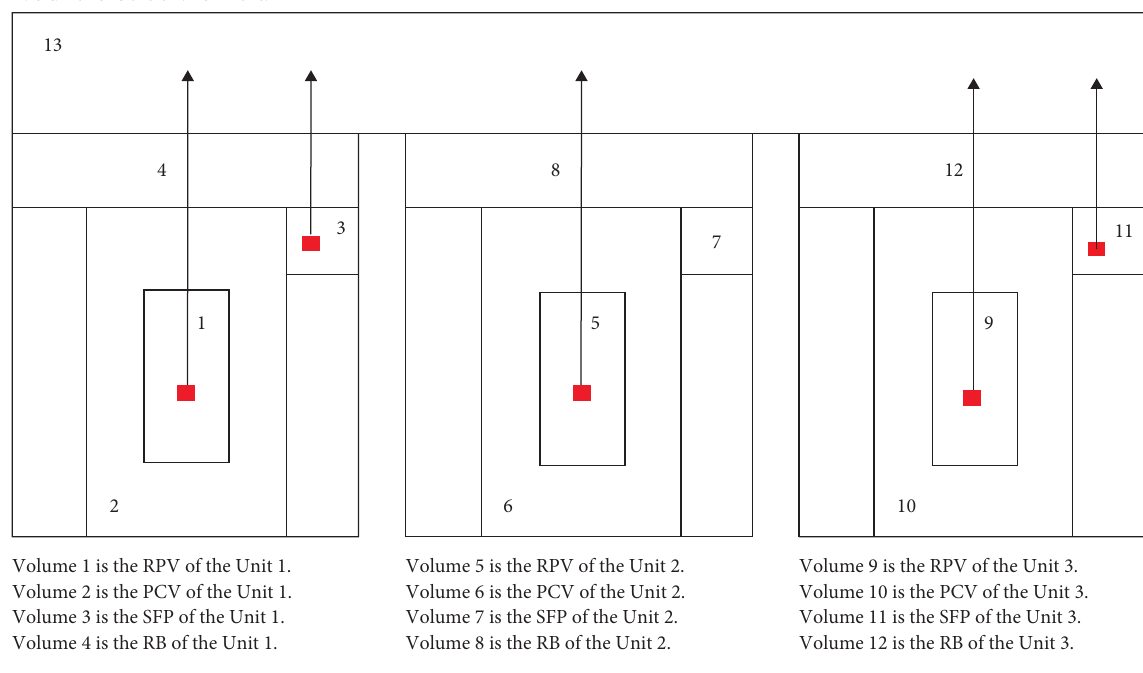
Figure 7: Nodalization and flow directions of case